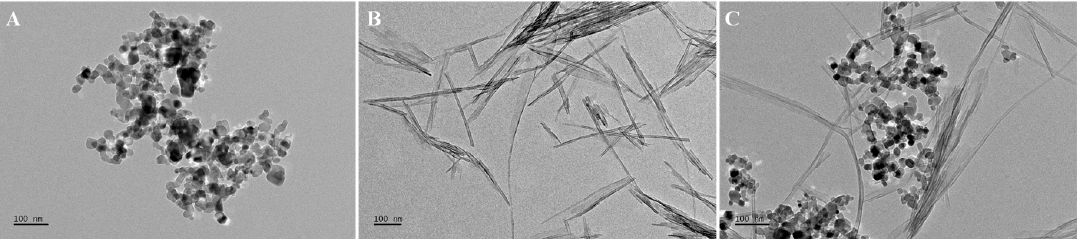
Figure 1. TEM images of the TiO 2 NPs (A), TiO 2 NTs (B), and TiO 2 NPs + NTs (C) in the algae medium.